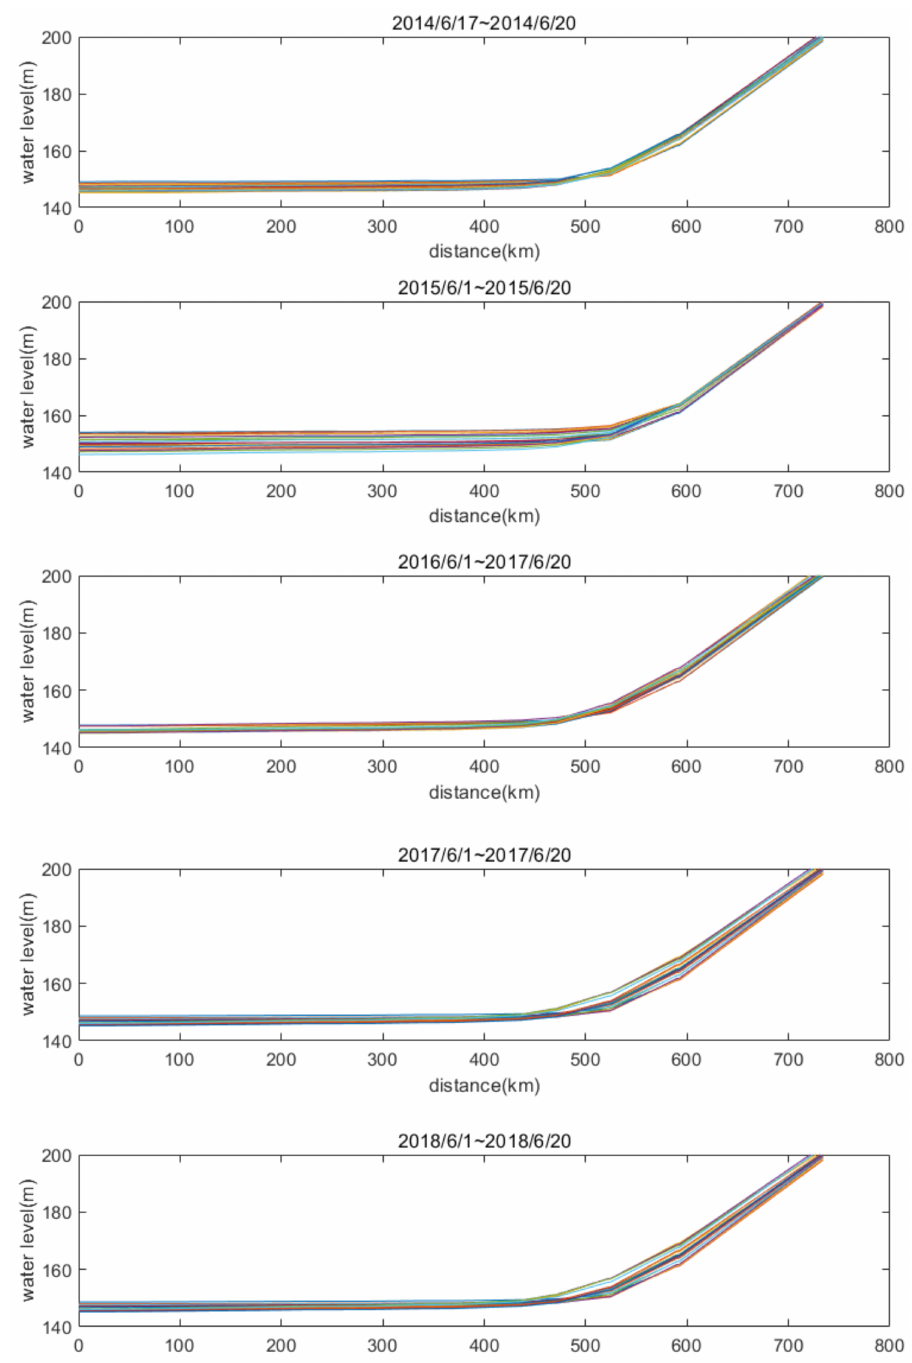
Figure 8. Water surface line during the early flood season from 2014 to